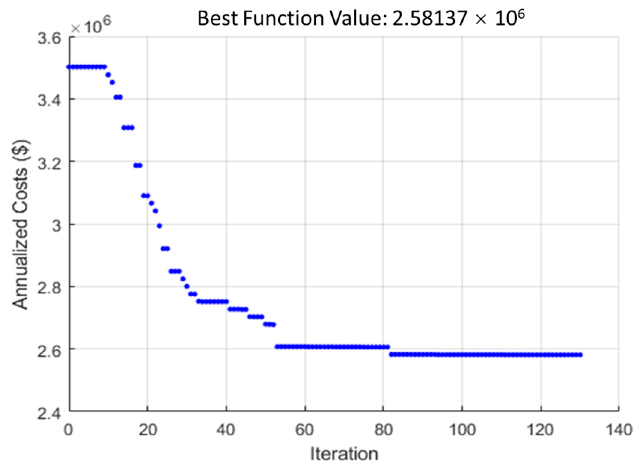
Figure 7. Particle Swarm Optimization (PSO) algorithm’s convergence plot.